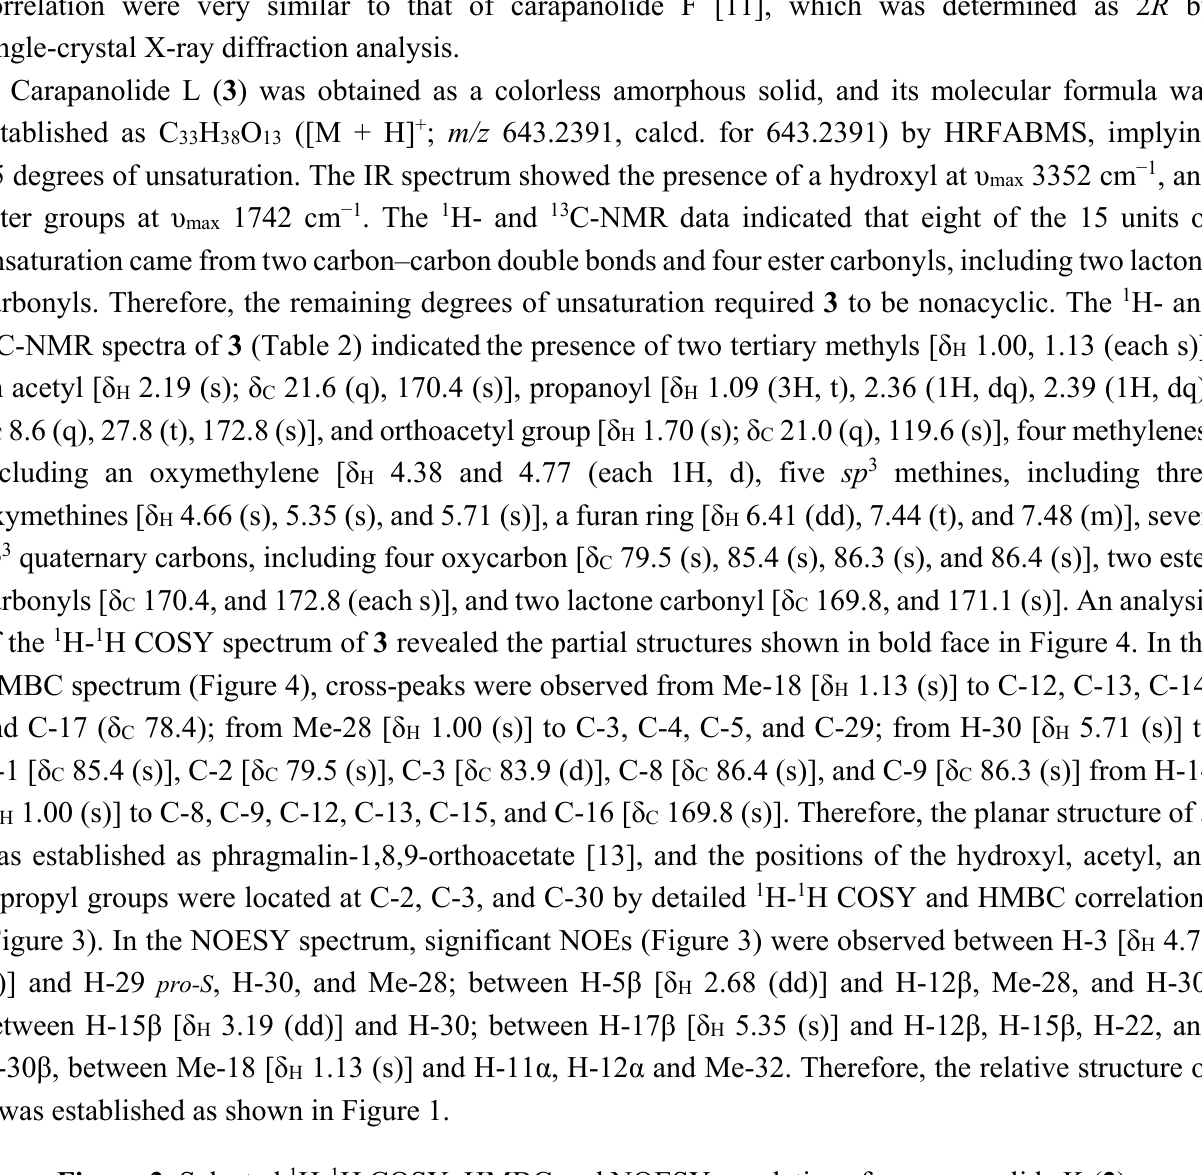
Figure 3. Selected 1 H- 1 H COSY, HMBC and NOESYcorrelations for carapanolide K ( 2 ). HMBC COSY